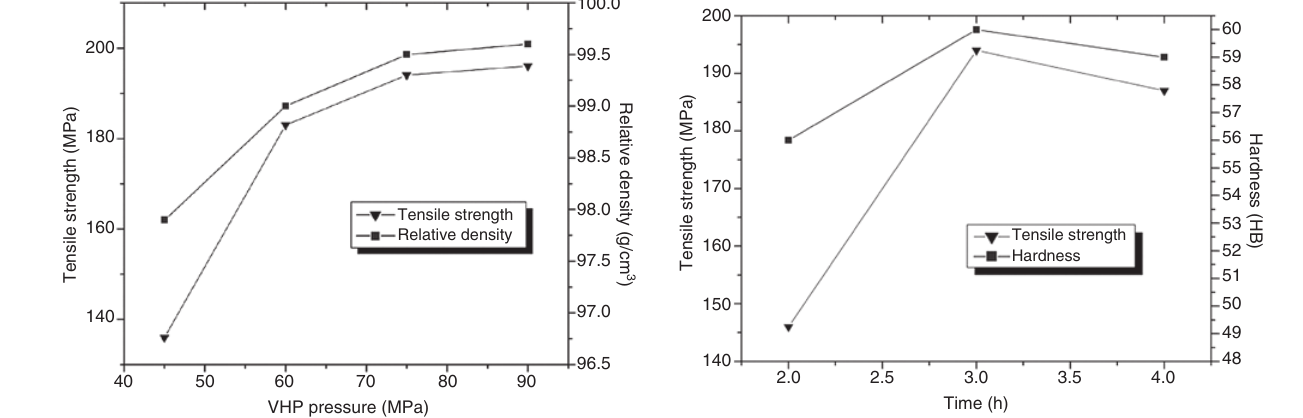
Figure 7 The variations in tensile strength and relative density of composites with varying vacuum hot pressing pressure.